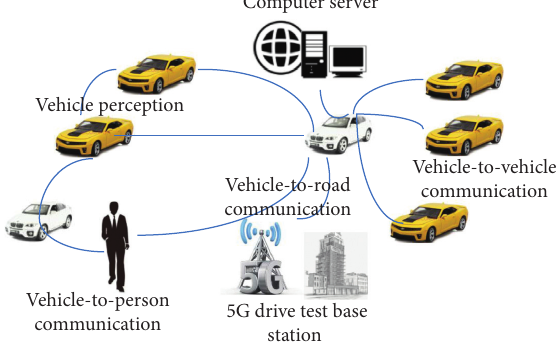
Figure 1: The Internet of Things converged 5G communication technology to get off the communication interconnection between “vehicles and vehicles,” “vehicles and person,” “vehicles and road,” and “vehicles and network service